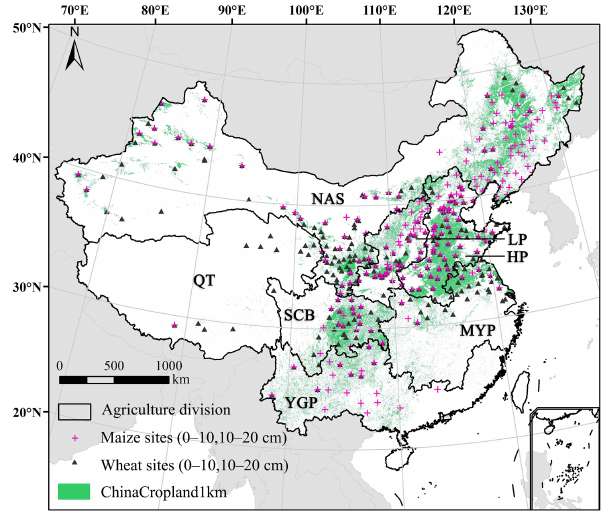
Figure 1. Study areas and SM in situ field monitoring sites in China. NAS: northern arid and semiarid region; LP: Loess Plateau; HP: Huang–Huai–Hai Plain; SCB: Sichuan Basin; MYP: middle– lower Yangtze Plain; YGP: Yunnan–Guizhou Plateau and southern China; QT: Qinghai–Tibet region; ChinaCropland1 km: the harvest- ing areas of crops across mainland